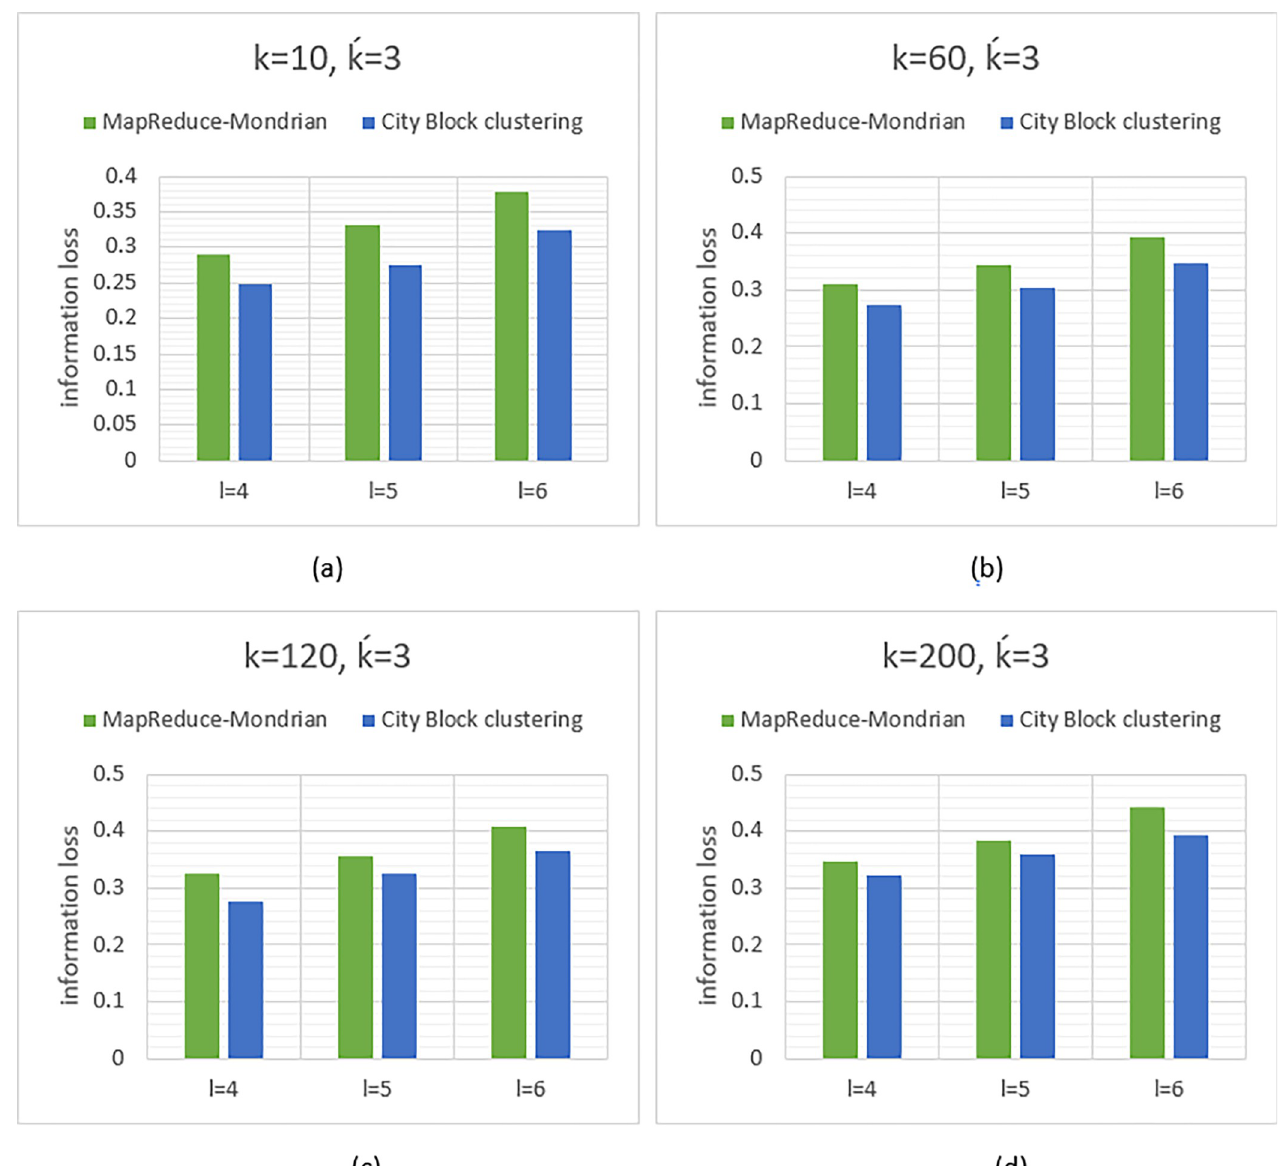
Fig 6. Information loss in anonymous poker hand with k´ = 3 and different values of k and λ .